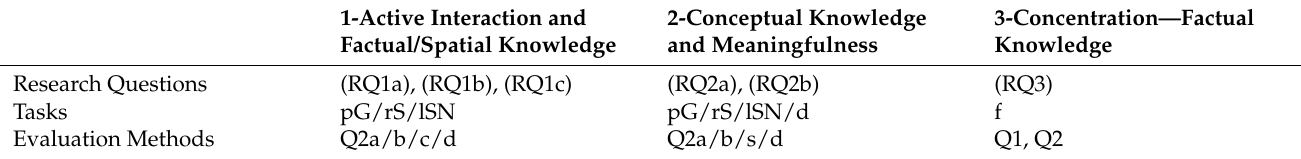
Table 1. The three main analyses and guiding research questions. Meanings of the abbreviations are found in Appendix